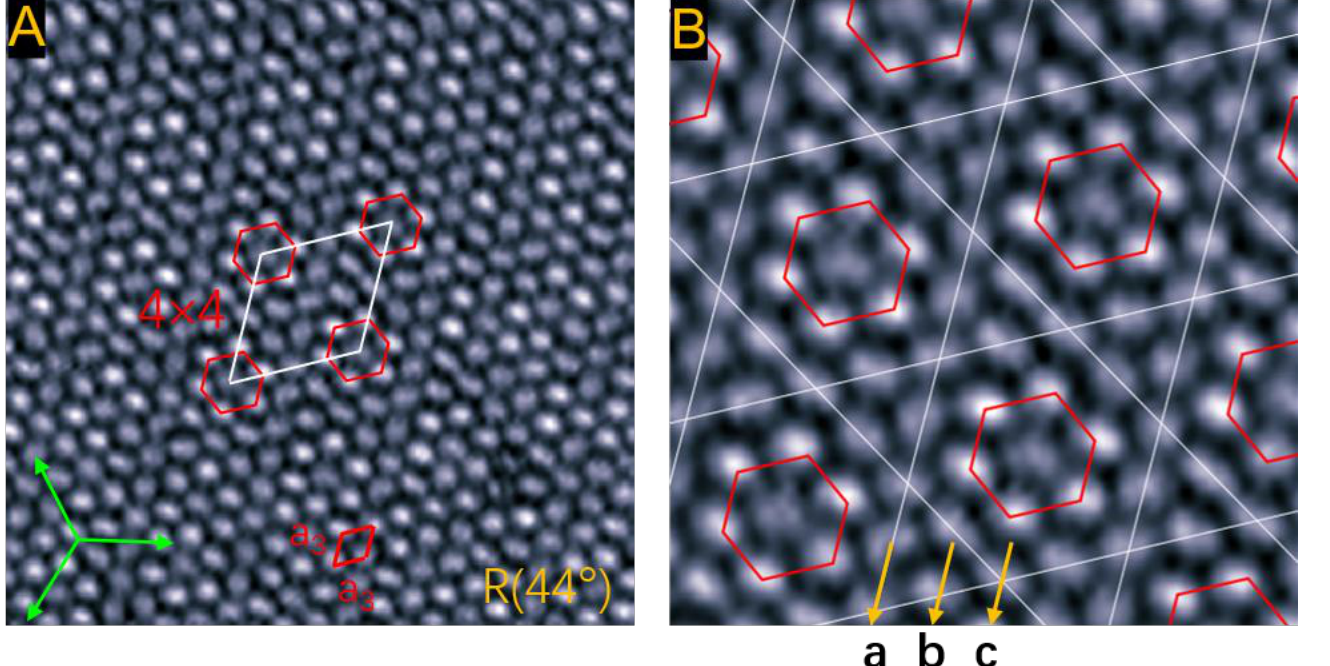
Figure 5. Kagome lattice formed at 310 K. ( A ) Symmetric kagome networks reveal a 4 × 4 superstructure in an R44 ◦ domain. The rhombus shows the primitive cell of the superstructure. 20 × 20 nm, 1.2 V. ( B ) Close-up view of the kagome network with each unit cell containing sixteen C 60 molecules, 1.2 V, 10 × 10 nm. The molecular rows a , b , and c contain dim molecules, alternate two bright and two dim molecules, alternate one bright and one dim molecule, respectively.